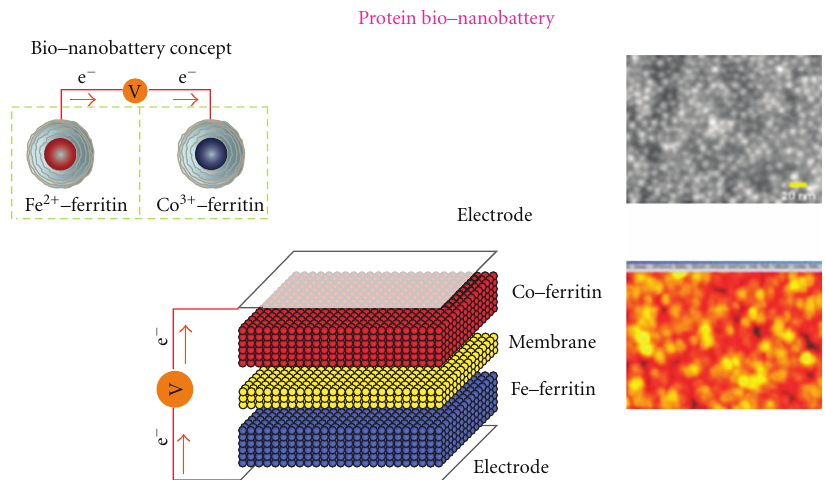
Figure 6: A multilayered ferritin bio-nanobattery for high coulomb capacity, high e ffi ciency, compact size, and flexible applications. The anodic and cathodic battery components are formed by alternating layers of oppositely charged ferritins. The blue is the anodic layer, and the red is the cathodic layer. The yellow membrane between the two layers is not needed if excess ferritins are not present. The image on the upper right is a SEM image of five layers of ferritin. The image on the lower right is an AFM image of five ferritin